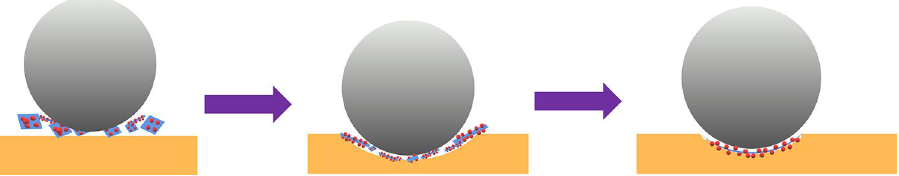
Fig.14 Schematic diagram of lubricant